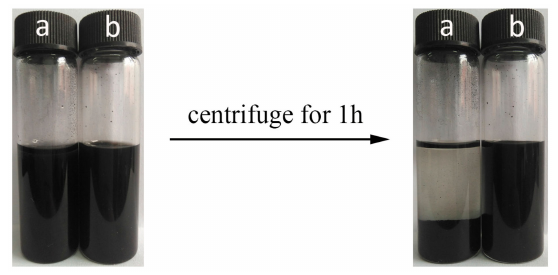
Figure 4. Dispersion photographs of ( a ) pristine c-MWCNTs and ( b ) c-MWCNTs/MG composite in DMAc before and after centrifugation.